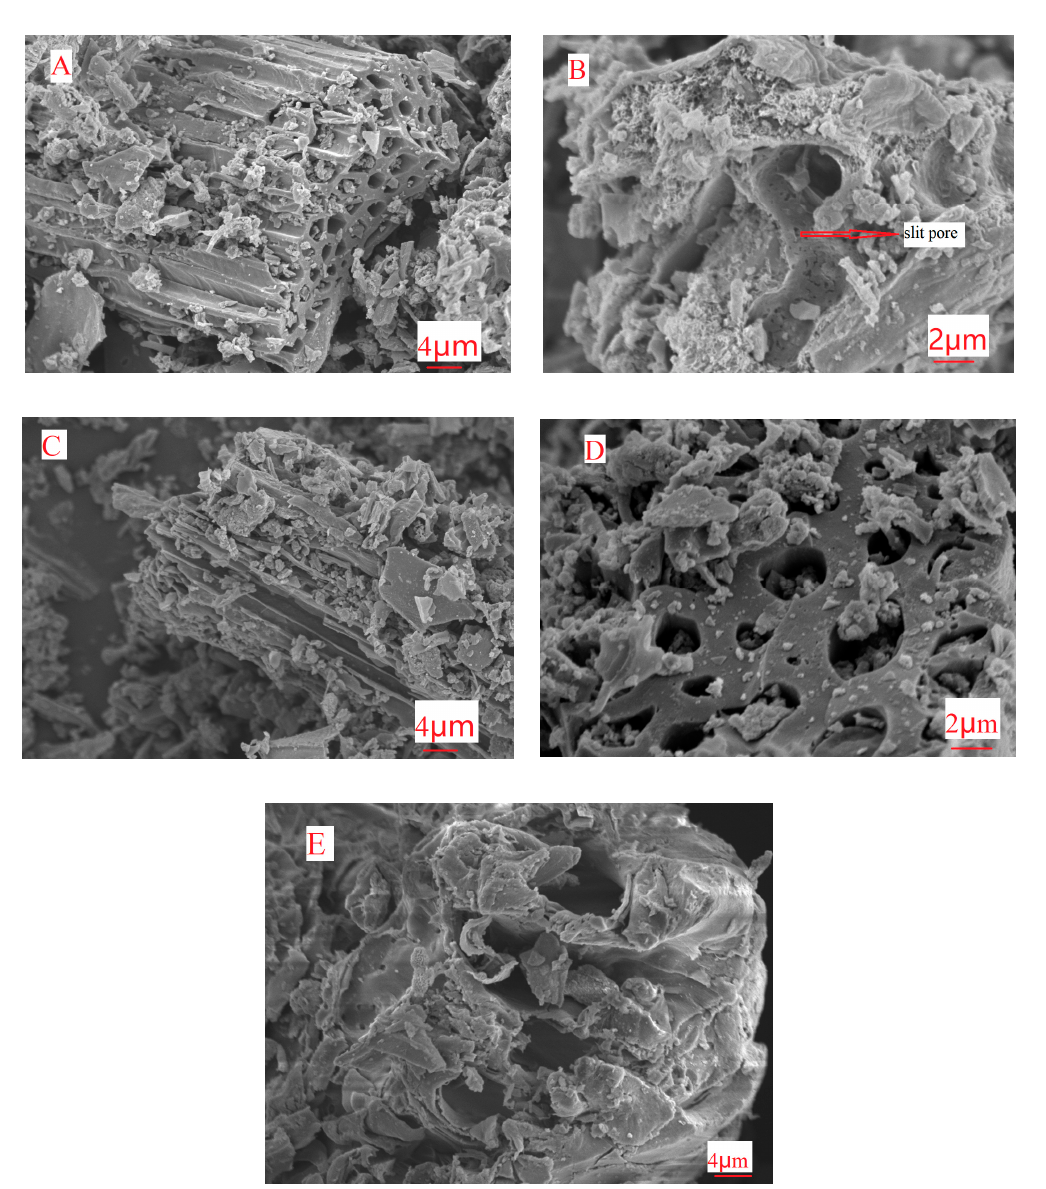
Figure 3. SEM Images of MRBCs ( A – D ) and RBC ( E ).